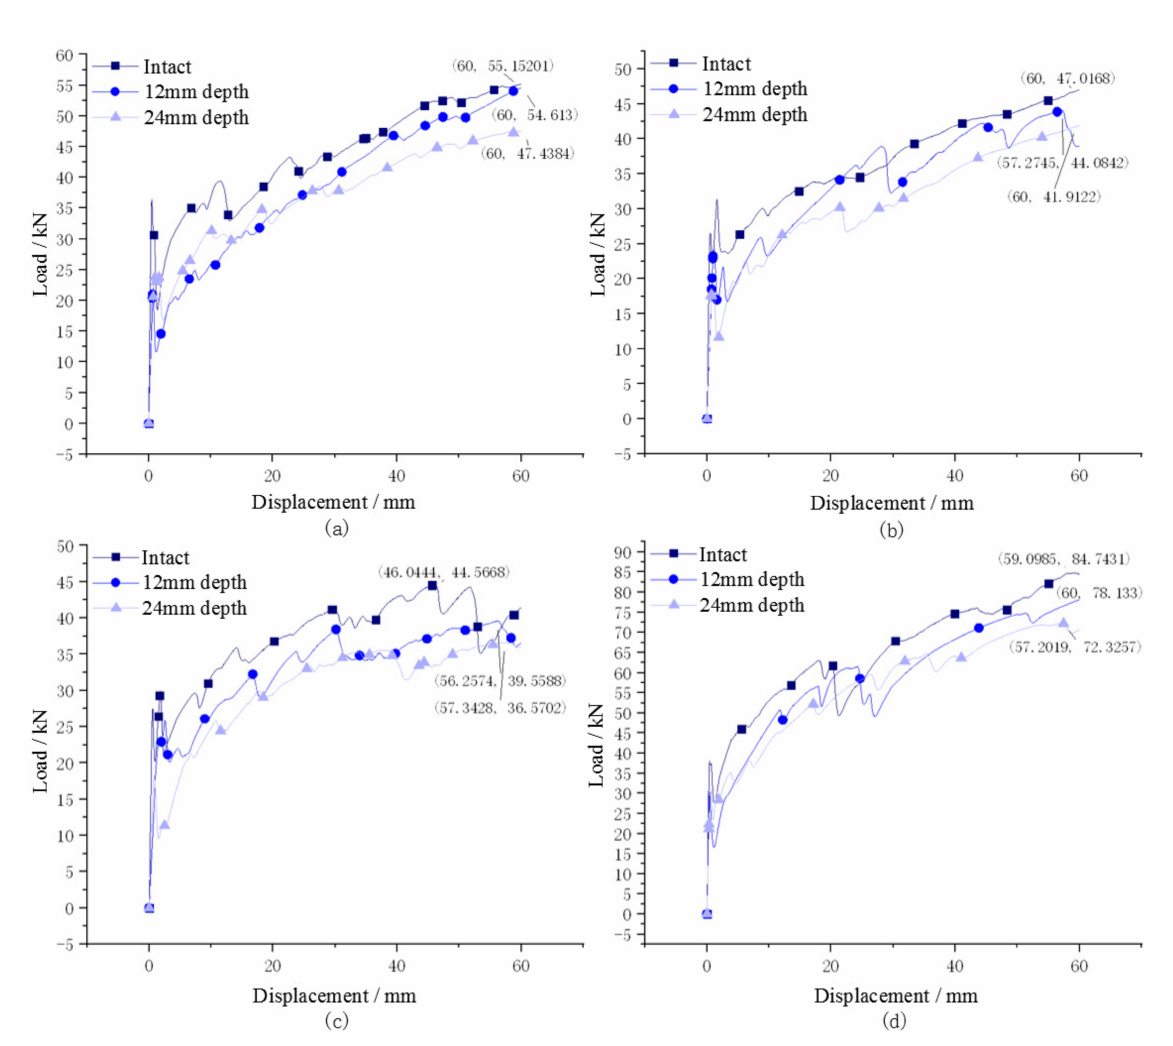
Figure 10. Effect of crack depth on ( a ) circular; ( b ) rectangular; ( c ) arched; and ( d ) trenched cable